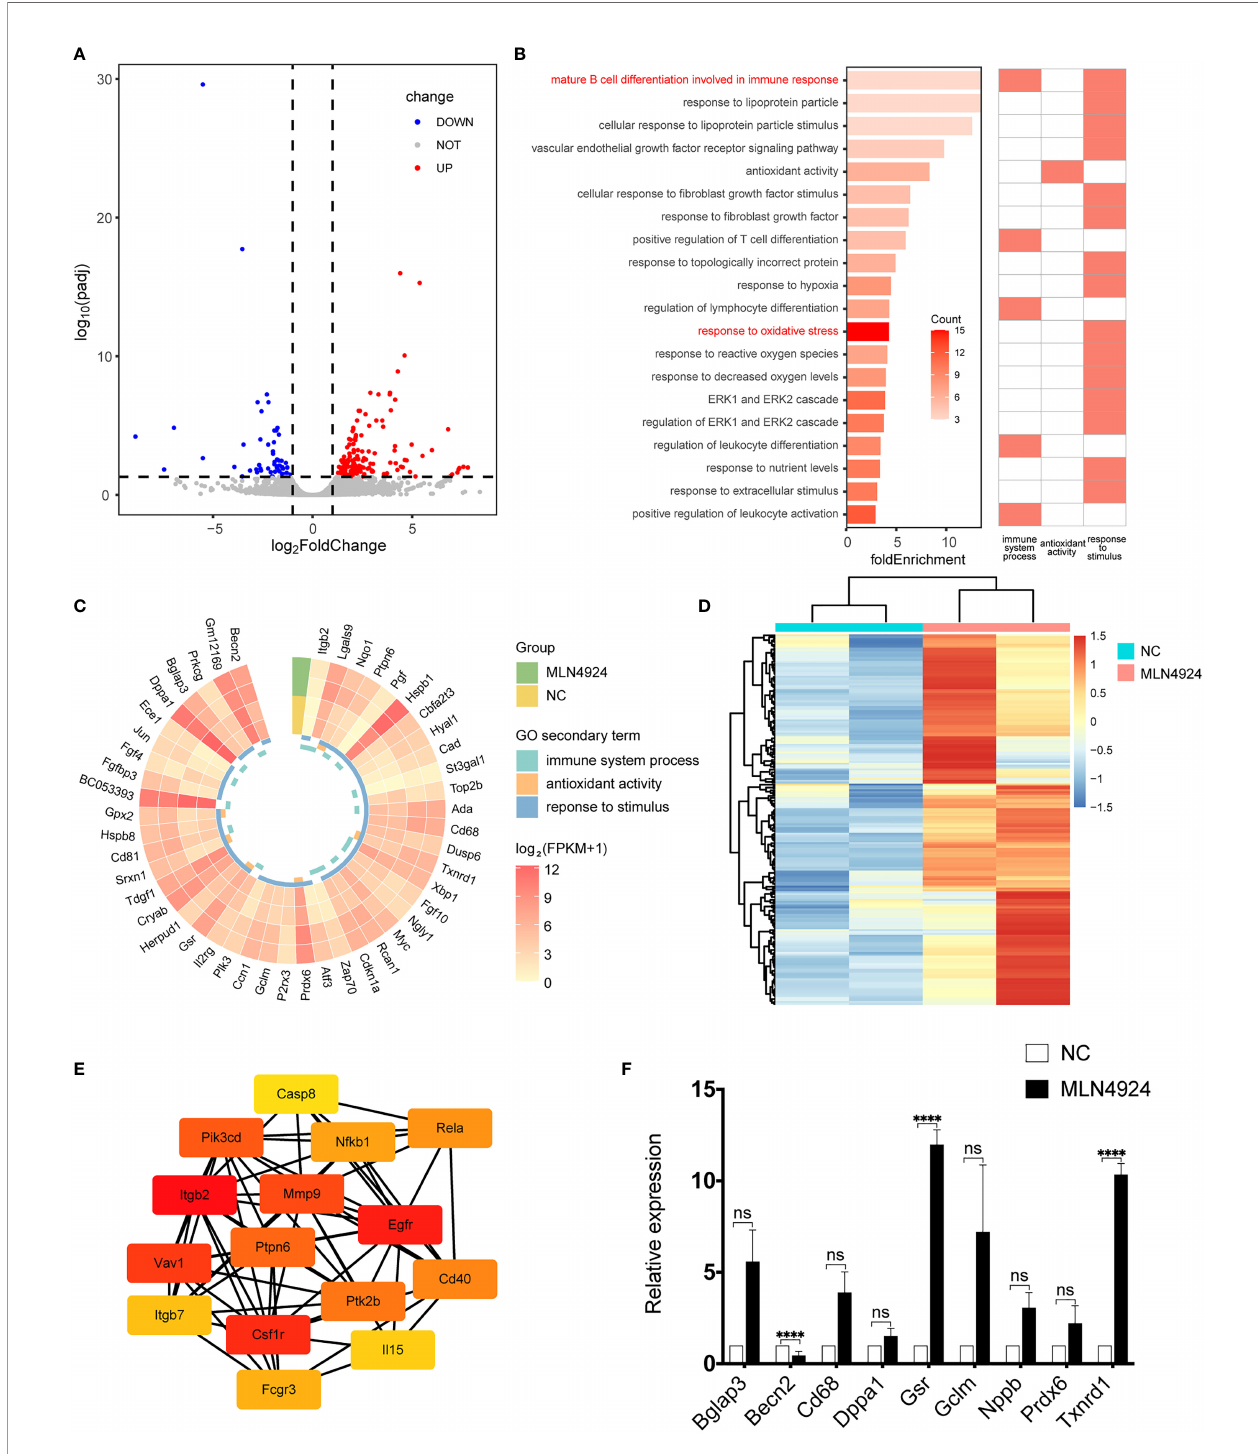
FIGURE 2 | Transcriptional pro fi le analysis and qPCR validation of NC and MLN4924-treated blastocysts. (A) The volcano plot showed the differentially expressed genes (DEGs) between the MLN4924-treated group and the control group. Each dot represents one gene. (B) GO enrichment analysis of DEGs, all terms that are related to the immune system process, antioxidant activity, and response to stimulus. (C) Gene expression level in related terms. (D) Heatmap of genes in terms associated with immunity, cytokines, and stimulus from GSEA enrichment analysis. (E) Hub genes identi fi ed from the PPI network from immune, cytokines and stimulus-related genes by cytoHubba plug-in. (F) Validation of DEGs by